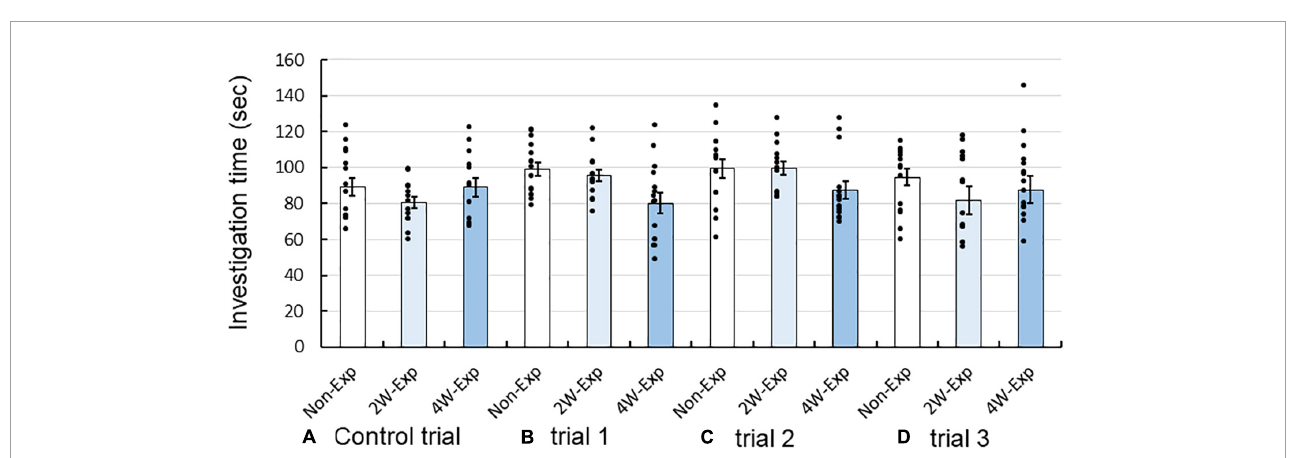
FIGURE4 Changes in investigation time of heterozygous oxytocin receptor (OXTR) ( ± ) mice after 2 or 4 weeks of repeated exposure to coffee odor. Investigation time of the non-exposure, 2-week, and 4-week exposure groups in the (A) control trial, (B) trial 1, (C) trial 2, and (D) trial 3. Black dots describe individual data. The statistical significance of the differences in the investigation time between the three groups was assessed using two-factor repeated-measure ANOVA followed by Bonferroni’s post-hoc